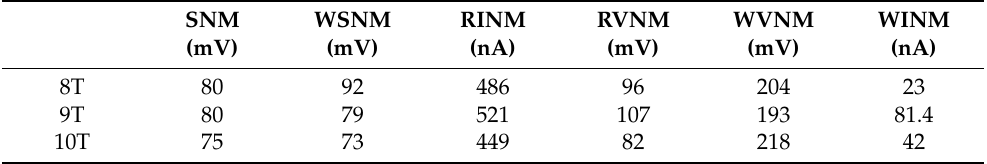
Table 2. Simulation data sheet.